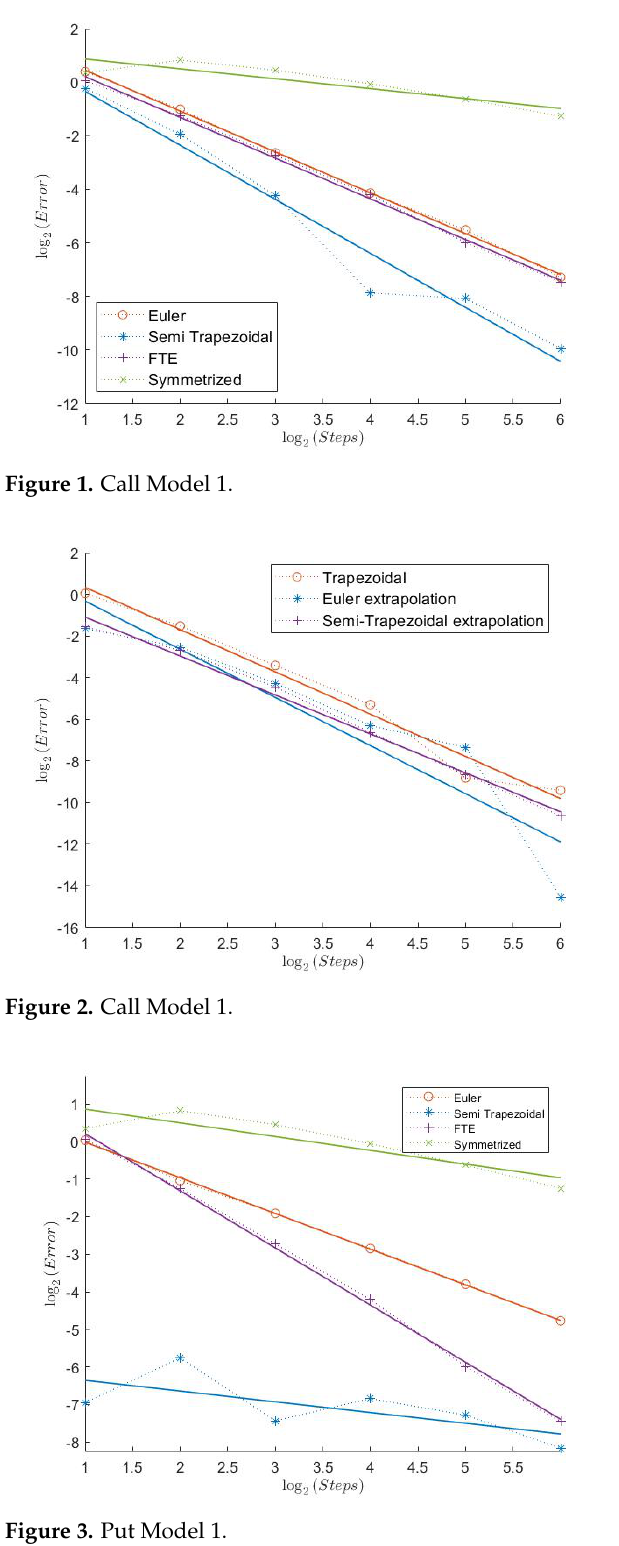
Figure 3. Put Model